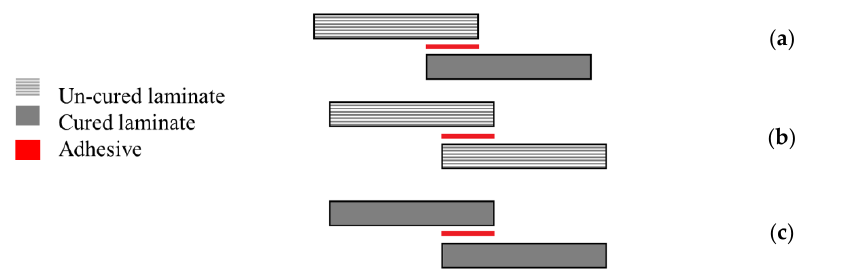
Figure 5. ( a ) Co-bonding, ( b ) co-curing, and ( c ) secondary bonding. Adapted from [38].